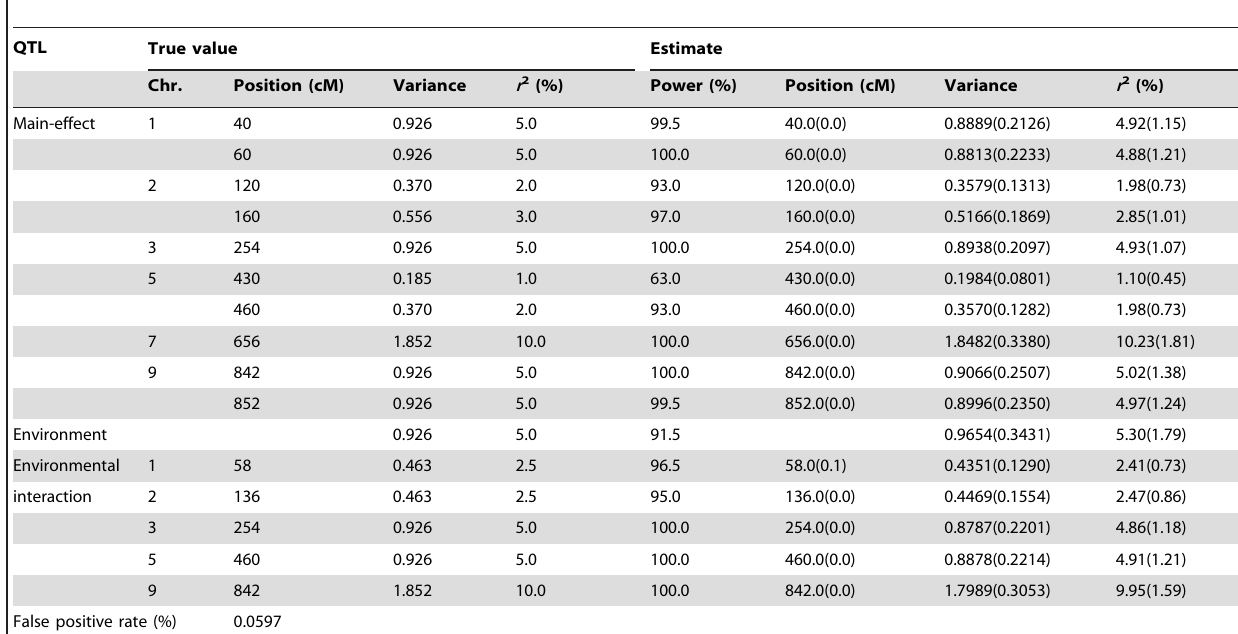
Table 4. Environmental interaction detection under the situations of large genome and high-density markers (200 replicates).